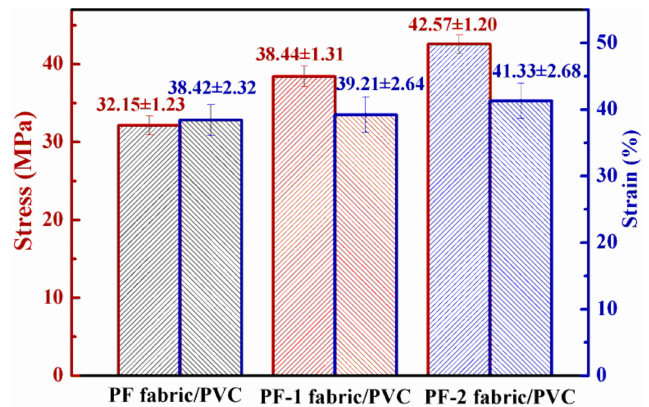
Figure 14. Tensile properties of PET fabric/PVC